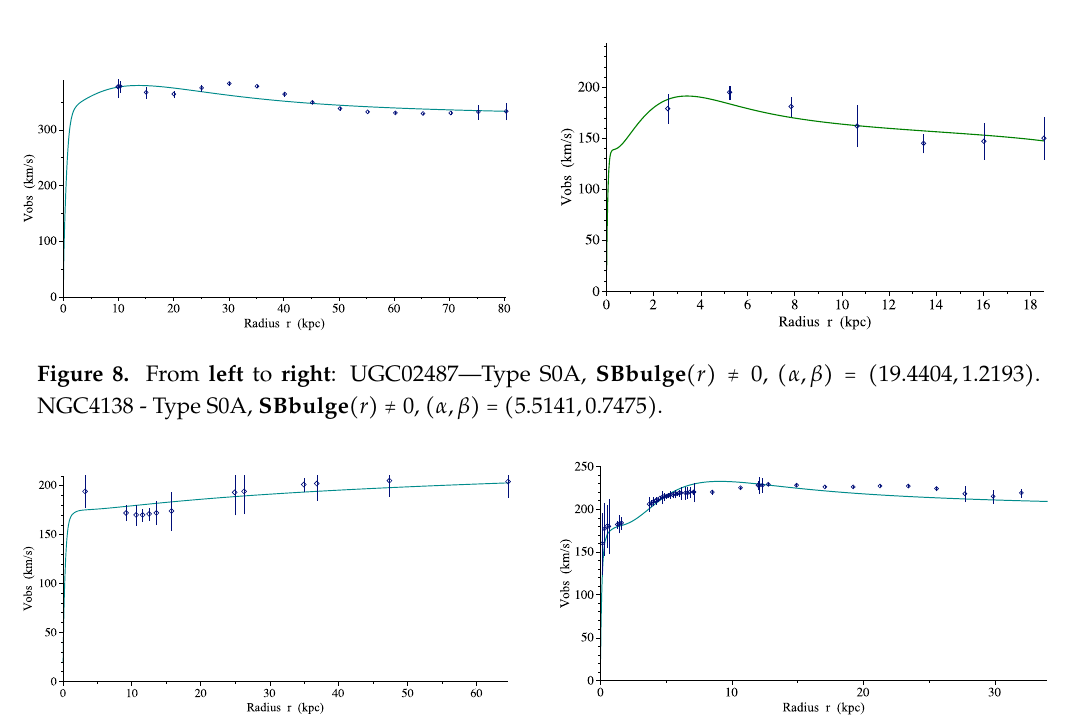
Figure 9. From left to right : UGC06614—Type SAa, SBbulge ( r ) ≠ 0, ( α , β ) = ( 5.3990,1.4964 ) .